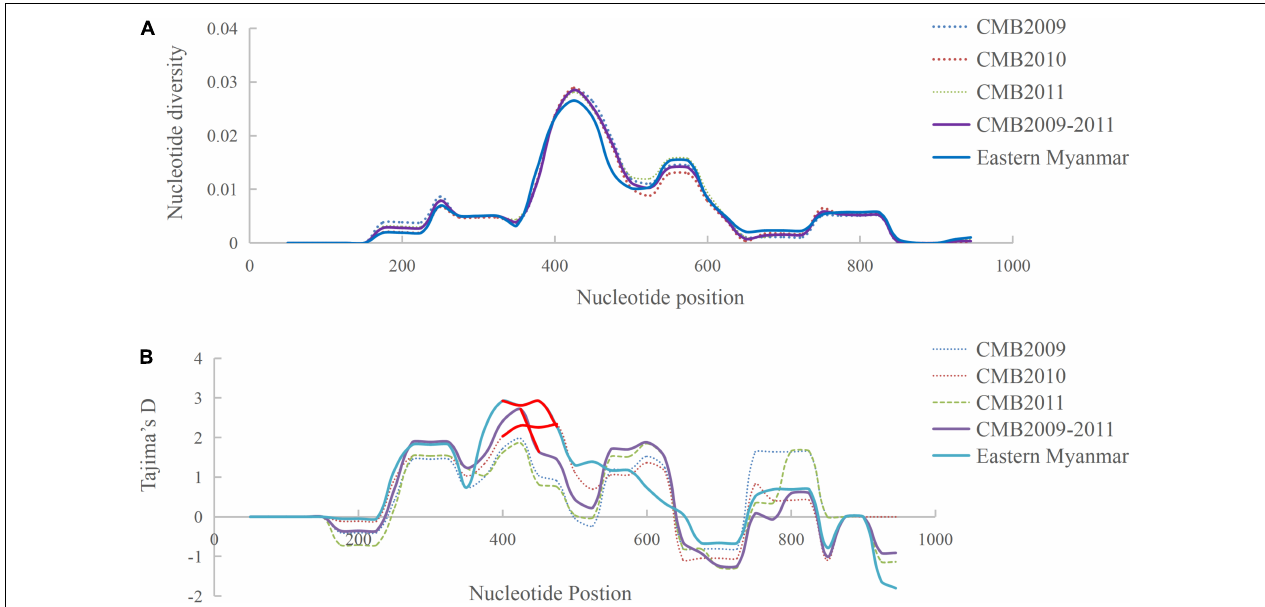
FIGURE 3 | Polymorphism and Tajima’s D tests of pvdbp -II sequences from CMB and eastern Myanmar isolates. (A) Sliding window plots of nucleotide diversity per site ( π ) comparing the level of genetic diversity at pvdbp -II. (B) Sliding window plots of Tajima’s D for pvdbp -II. Statistical significant sites are marked with red lines.